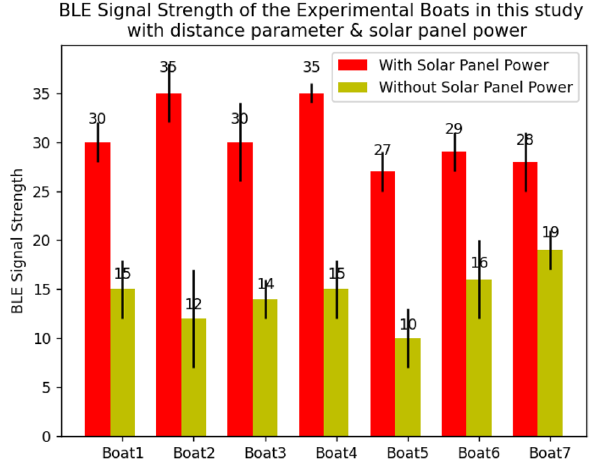
Fig. 12 Experimental result of BLE signal strength with distance parameter a red line indicated BLE signal strength will be higher if the boat is equipped with solar panel to achieve more far distance; b brown line indicated BLE signal strength without any solar panel resulting short distance hours of